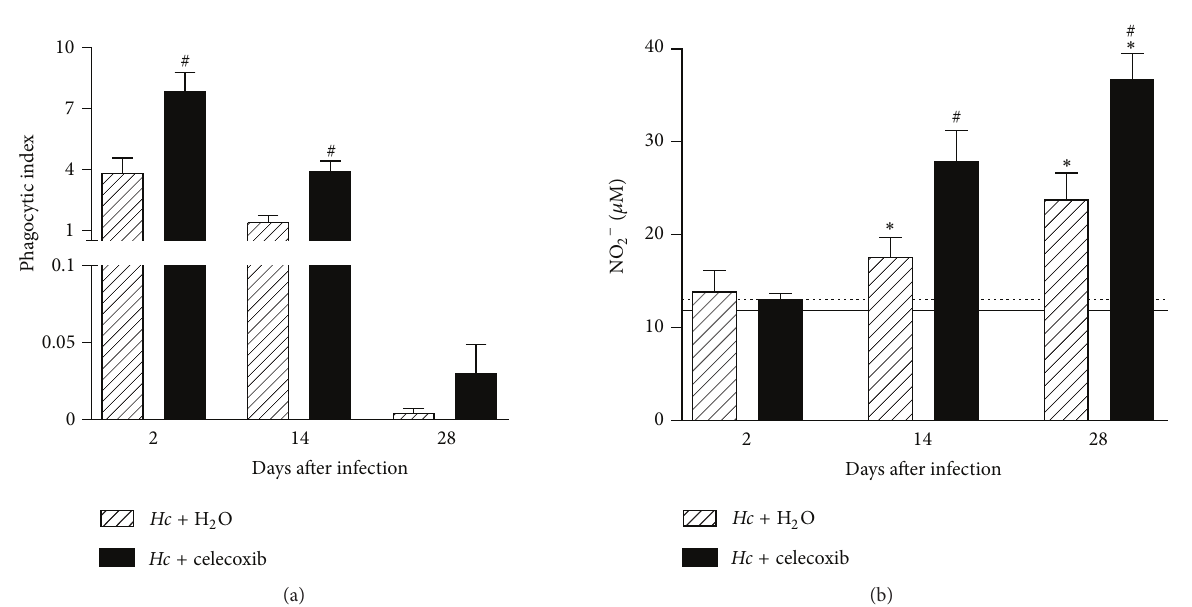
Figure 2: Celecoxib treatment increases the phagocytosis of yeast by alveolar macrophages in vivo and NO production in the lung parenchyma. (a) The BALF cells from mice infected with a sublethal inoculum of H. capsulatum , with or without celecoxib treatment, were collected and stained after cytospin preparation. The yeast cells in the alveolar macrophages were counted using bright-field microscopy at 100x magnification. The phagocytic index was calculated as described in Section 2. (b) The NO 2− production in the lung parenchyma was measured using Griess reagent. The data are presented as the means ± SEM representative of three independent experiments (𝑛 = 5 - 6) . One- way ANOVA (Tukey’s multiple comparison test) was used. ∗ PBS + H 2 O versus Hc + H 2 O or versus Hc + celecoxib; # Hc + H 2 O versus Hc + celecoxib 𝑃 < 0.05 .